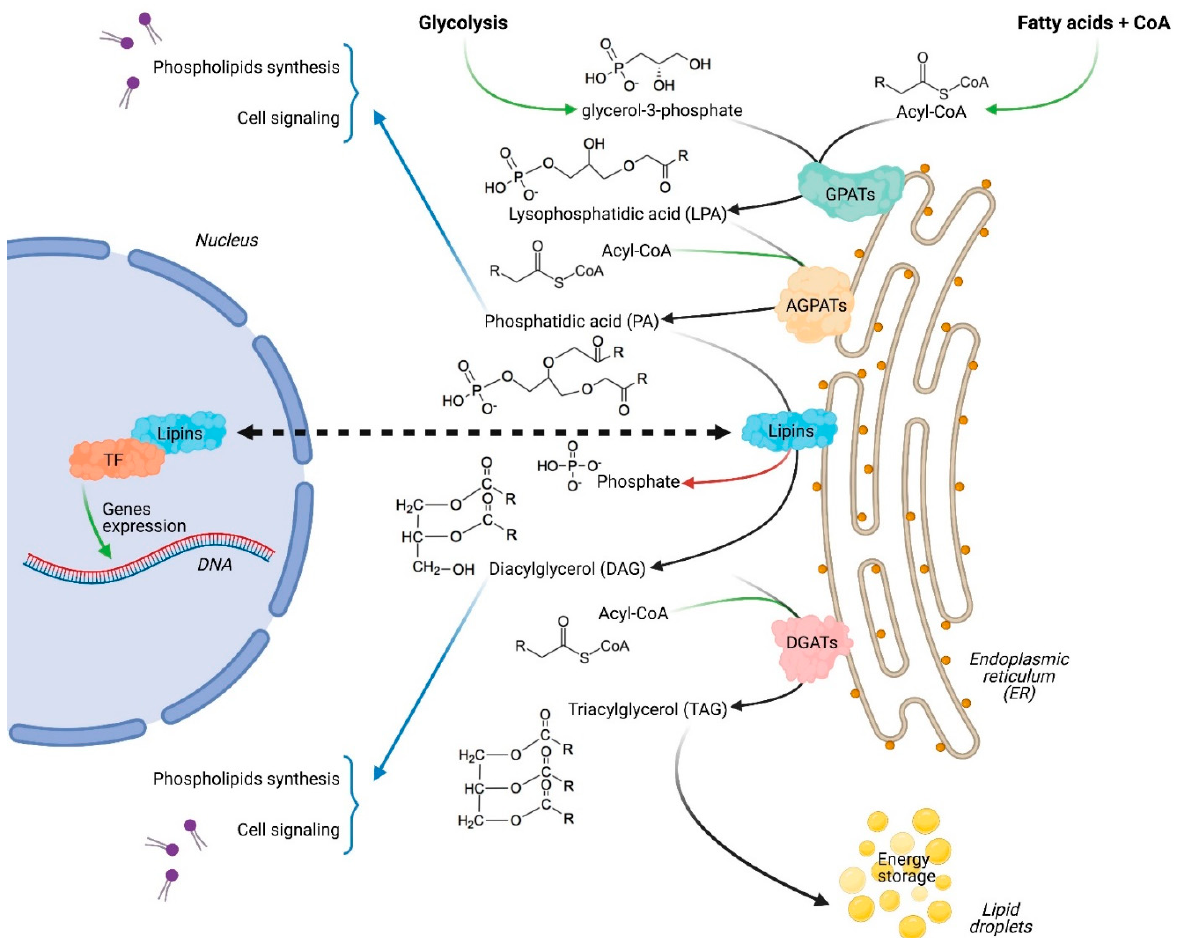
Figure 1. The dual function of lipins as enzymes in the glycerol-3-phosphate pathway on the endoplasmic reticulum and as transcriptional regulators in the nucleus by interacting with several transcription factors (TF).